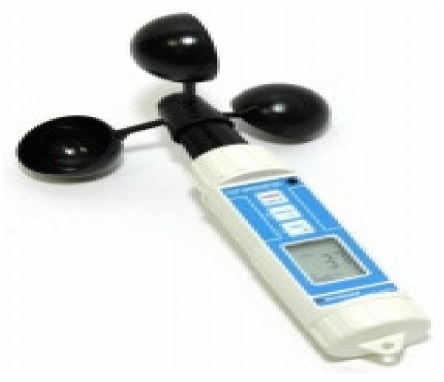
Figure 8. Cup anemometer.